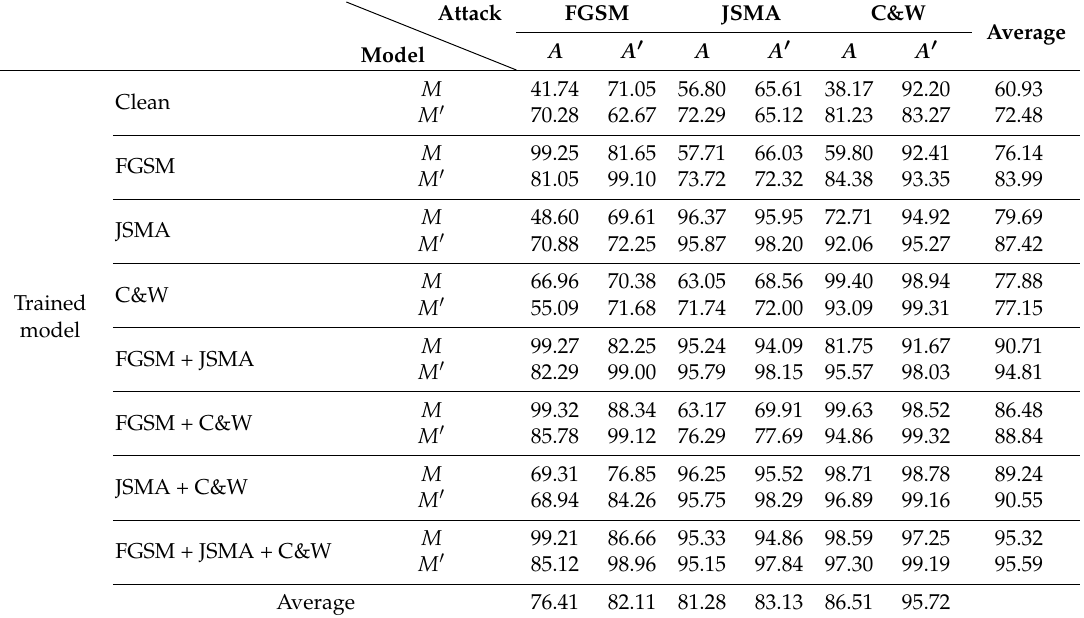
Table 5. Test accuracy of LeNet5 networks on adversarial examples. M denotes a network model trained using data augmentation, while M (cid:48) is a network trained without data augmentation. A is the set of adversarial examples generated from a target network trained with data augmentation, while A (cid:48) is the set created from a network trained without data